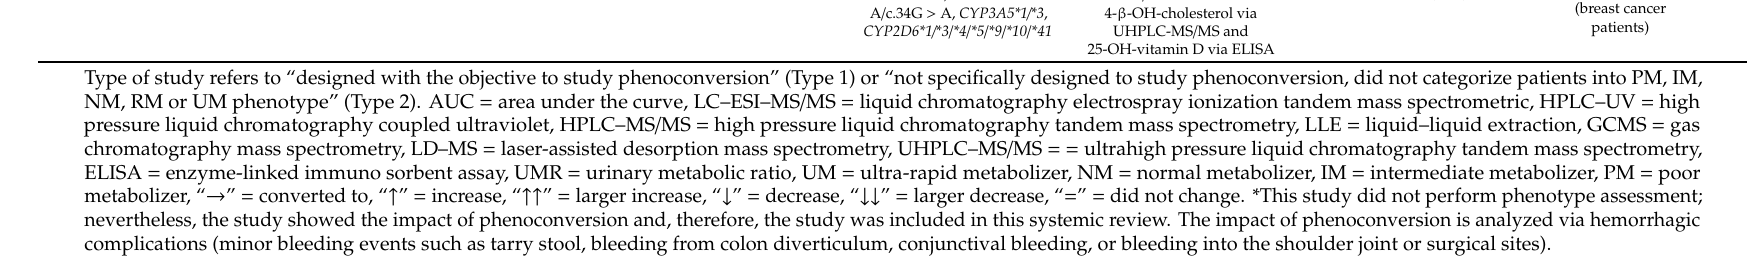
Table 2. The impact of phenoconversion on CYP450 metabolism that results from the use of patient- and disease-related